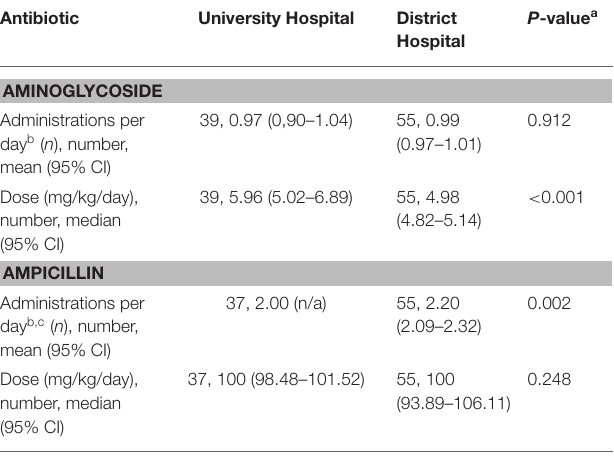
TABLE 4 | Doses of aminoglycosides and ampicillin among term born infants first 10 days of life in two Norwegian neonatal units, 2017.